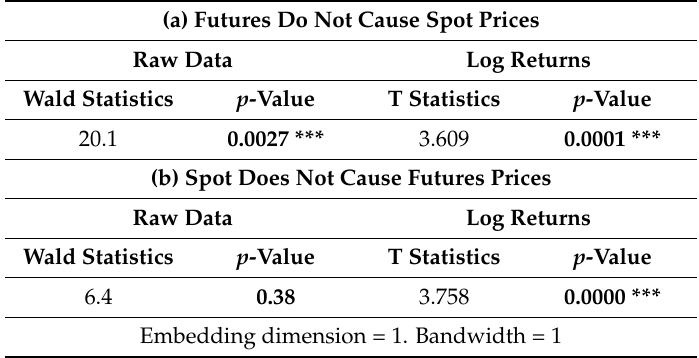
Table 4. Non-linear Granger causality test between long-term futures prices estimated by a stochastic model and spot prices.